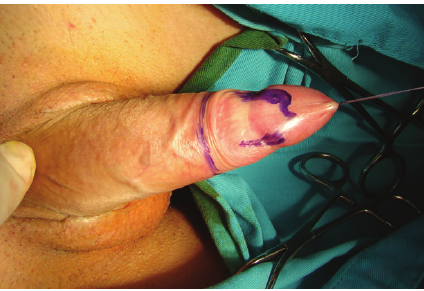
Figure 1: Marked incision lines for clitoroplasty and vaginoplasty.